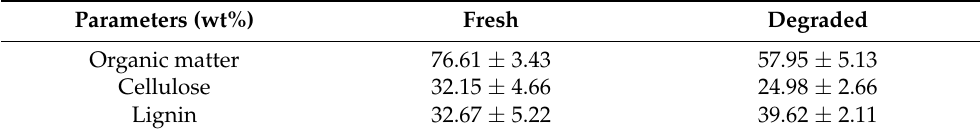
Table 2. Lignocellulosic components in the fresh and degraded mulch. Parameters (wt%)